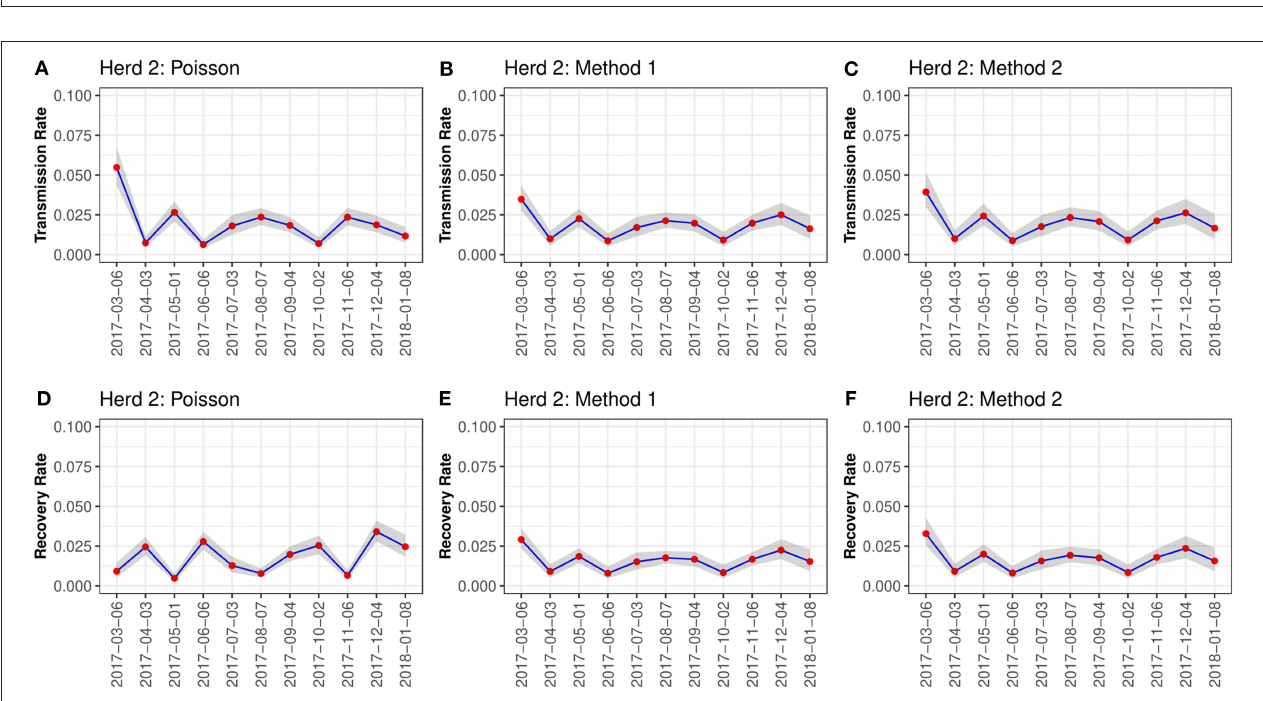
FIGURE 3 | Rates for Herd 2. This figure shows the estimated transmission and recovery rates for Corynebacterium spp. over time during the 12-mo sampling period for herd 2 in this study. Three methods were used to calculate the estimates; Poisson regression (A,D) , Method 1 (B,E) , and Method 2 (C,F) .